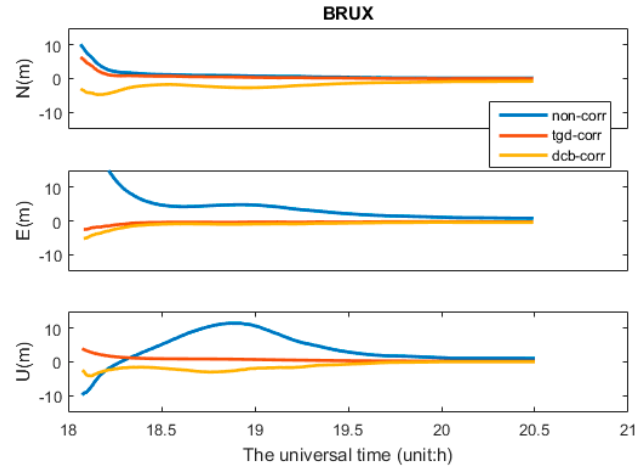
Figure 10. Positioning results (N, E, and U) of b1b3-based Galileo PPP.